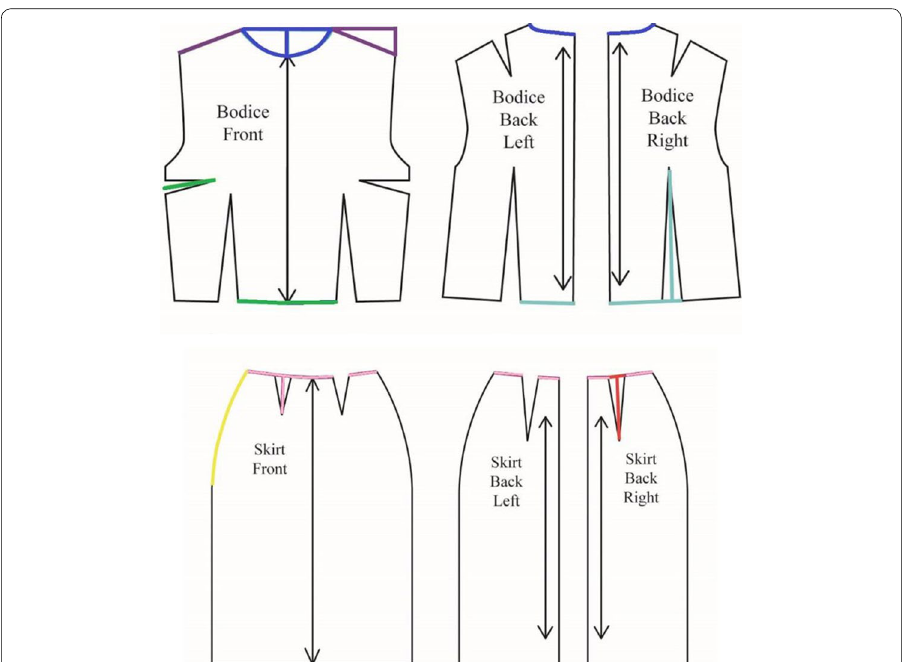
Fig. 5 Color-coded pattern-block